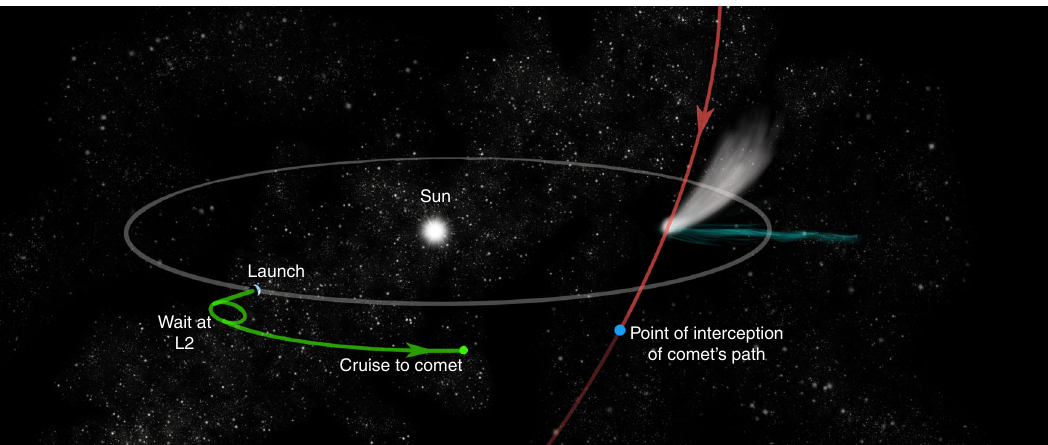
Fig. 1 Sketch of mission phases. The spacecraft launches from Earth and waits at L2 until a suitable comet is discovered, before departing on an interplanetary cruise to be in the right place at the right time to intercept the comet as it crosses the ecliptic plane. The smaller probes are released just before arriving at the comet. The trajectory of the spacecraft is in green, while the comet ’ s orbit is in